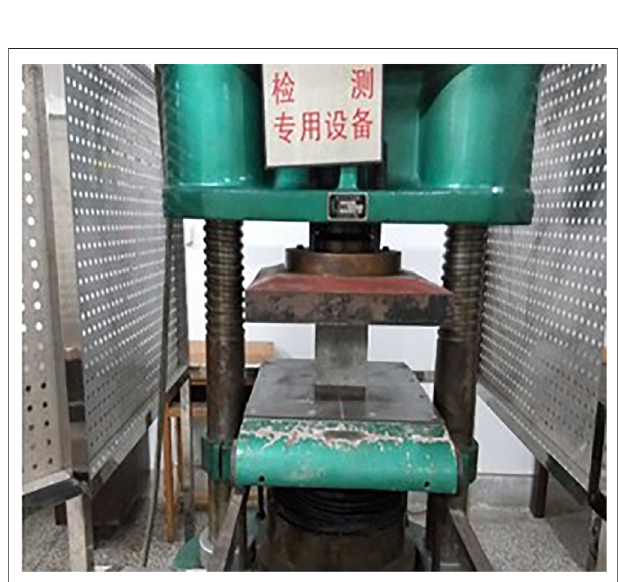
FIGURE 7 | Concrete performance test device.